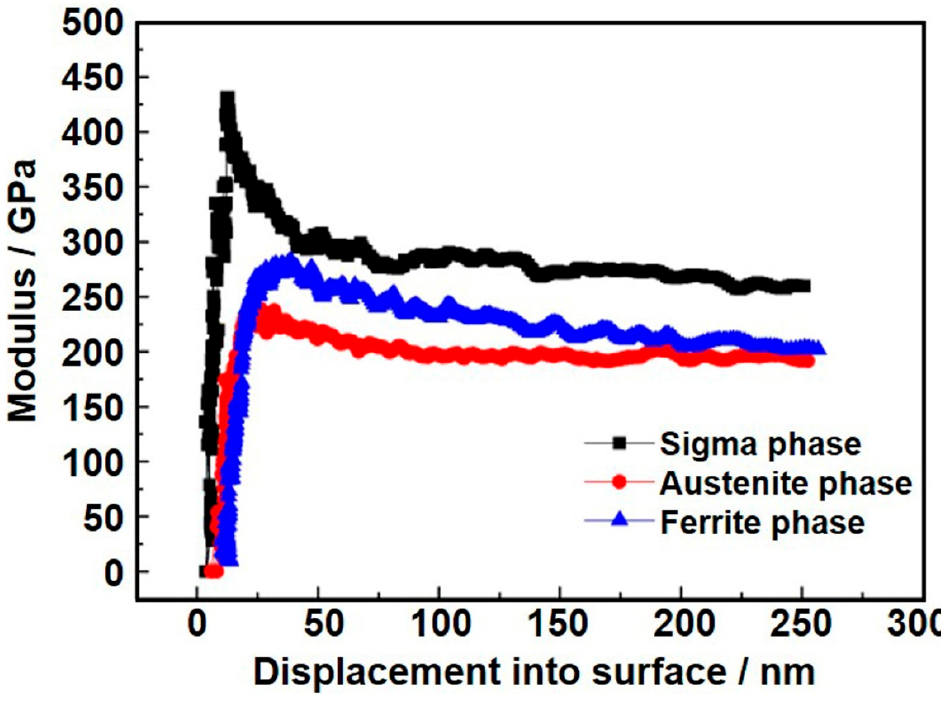
Figure 5. Moduli of sigma, austenite, and ferrite phases in aged Z3CN20.09M specimens at 750 °C for 200 h examined by nanoindentation.